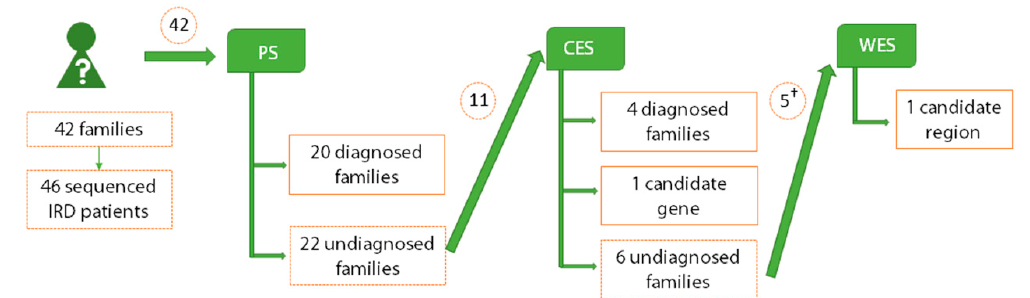
Figure 1. Summary of the applied pipeline and global diagnostics results. The application of panel sequencing (PS) allowed the genetic diagnosis of 20 of the 42 families included in the